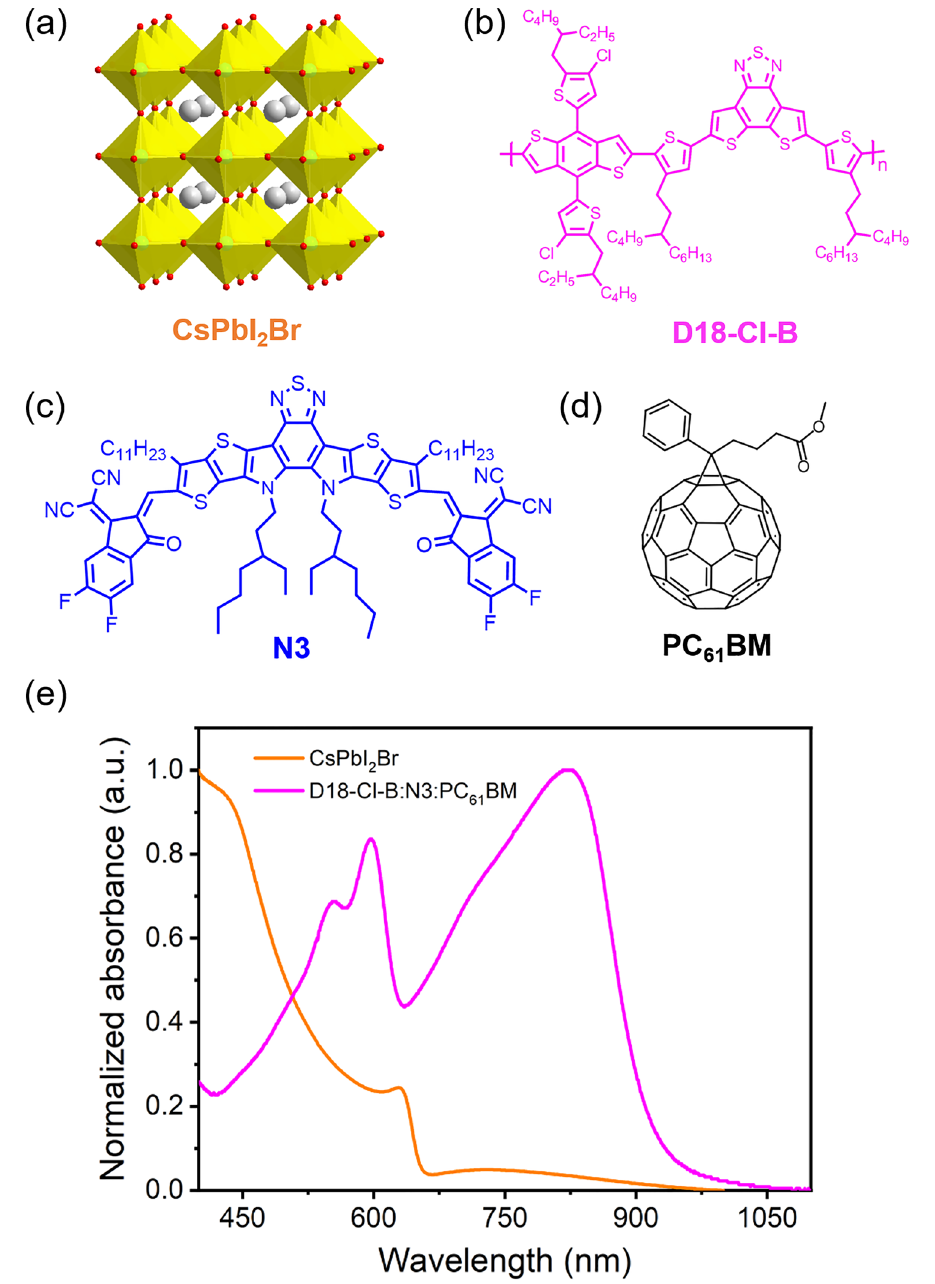
Fig. 1 a Crystal structure of CsPbI 2 Br. b–d chemical structures for D18-Cl-B, N3, and PC 61 BM. e UV–Vis absorption spectra for CsPbI 2 Br and